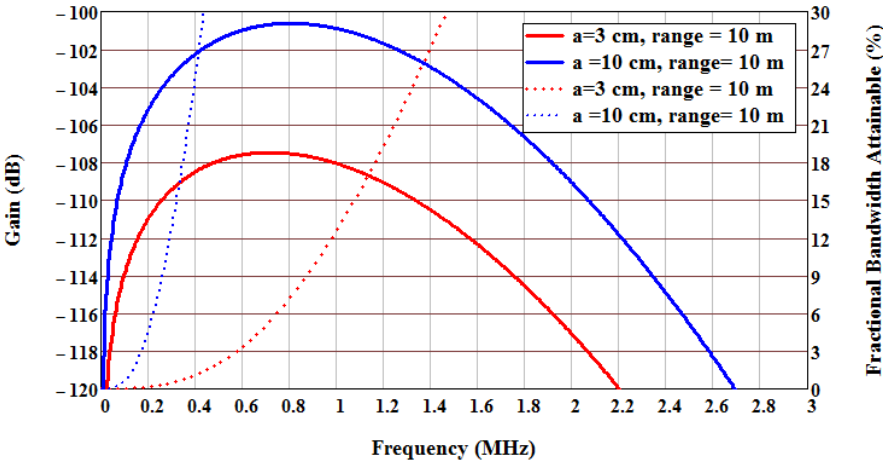
Figure 6. Gain and fractional bandwidth versus frequency considering EM path loss, SAW propagation loss, and antenna size. Two antenna sizes, 3 and 10 cm radius, are shown for illustration. The range was chosen at 10 meters, and EM propagation loss increases at 40 dB/decade with increase in range, assuming isotropic radiation. Gain Equation (solid lines) and fractional bandwidth (dotted lines) are plotted versus